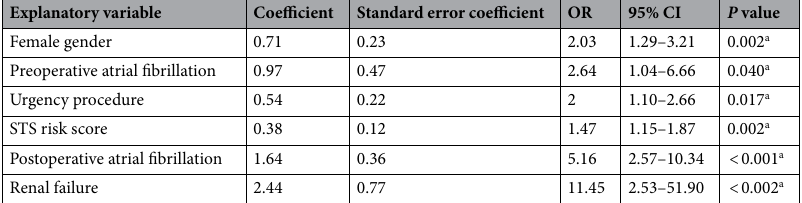
Table 2. Multiple regression model to predict postoperative stay > 5 days after cardiac surgery. a P value < 0.05; CI: confidence